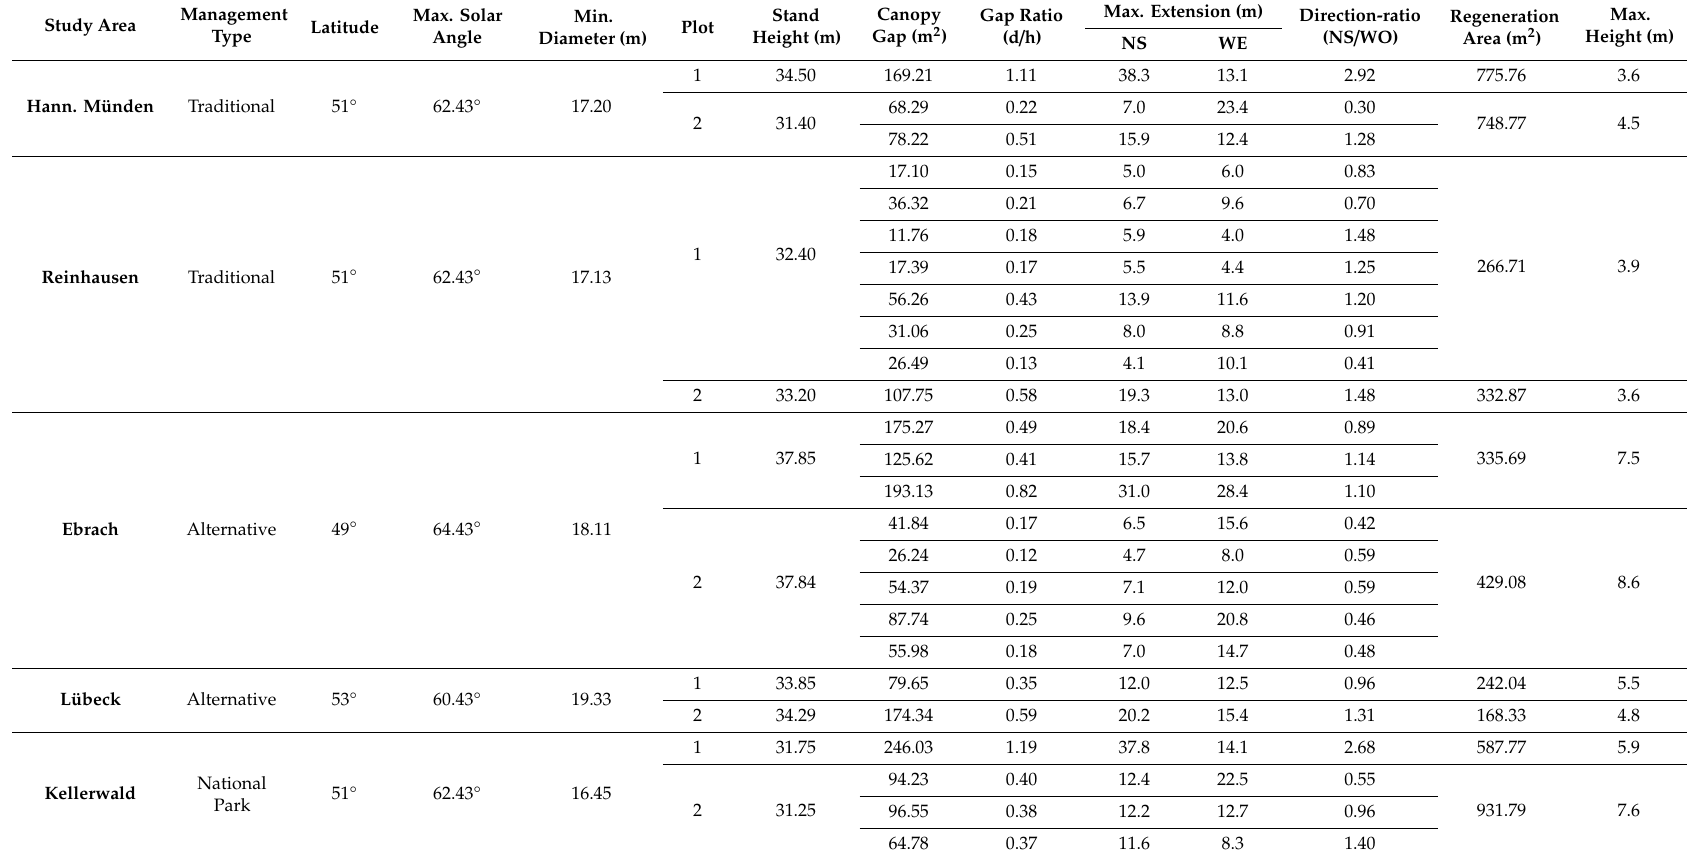
Table 2. Detailed information about latitude, maximum solar angle, stand height and the theoretical, minimum diameter of a circular gap at which the solar radiation directly hits the forest floor, maximum regeneration height, sizes of regeneration areas and canopy gaps, as well as a description of the spatial extent of the canopy gaps in north-south (NS) or west-east directions (WE). Every time there are multiple values of gap area for one plot, several small gaps were summed-up in terms of canopy opening size, which then was the basis for averaging gap sizes and further